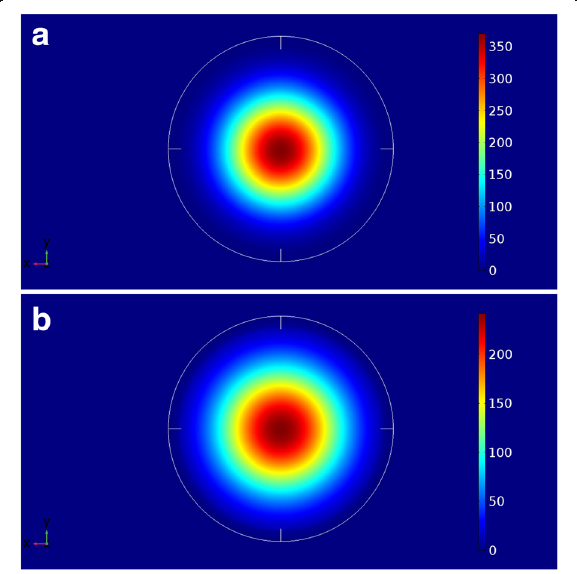
Fig. 4 Squared electron ground state wave function for 35-nm- diameter Ge 0.72 Sn 0.28 QD for a Xb = 6% and b Xb = 22%